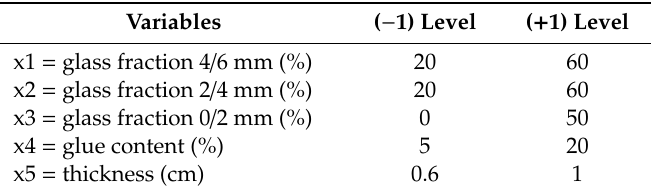
Table 3. Experimental domain of the